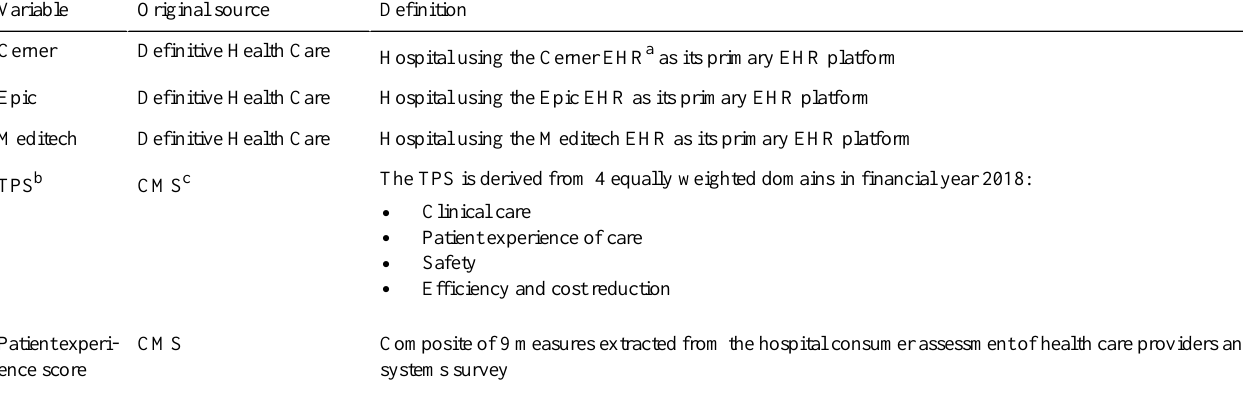
Table 1. Variables and operational definitions. DefinitionOriginal